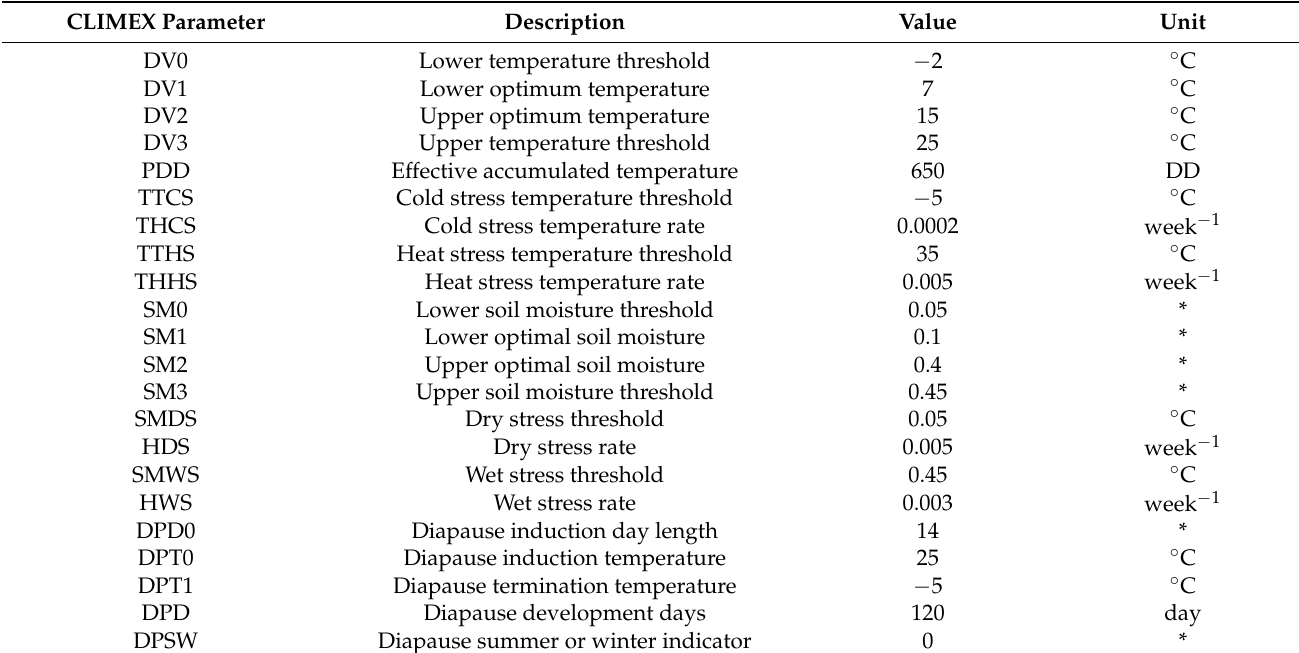
Table 1. CLIMEX parameters of Apocheima cinerarius